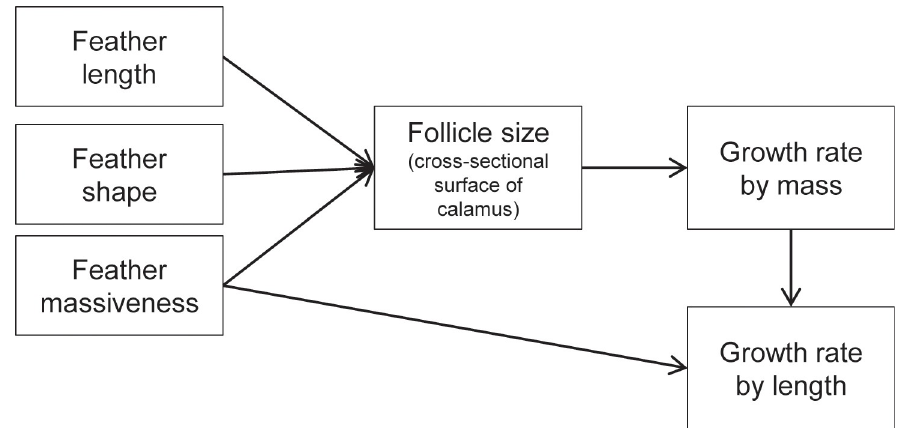
Fig 5. Schematic representation of the determinants and constraints of feather growth rates, as suggested by this study.